Question: Briefly state, in one sentence, what is plotted here.
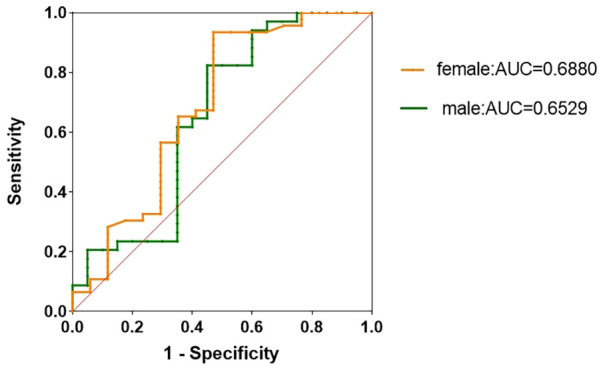
Answer: The ROC curve to distinguish between stable or unstable fractures in different genders. The AUC value was 0.65 in male patients ( n = 54) and 0.69 in female patients ( n = 63). Corresponding optimal cutoff values and diagnostic parameters were marked respectively.